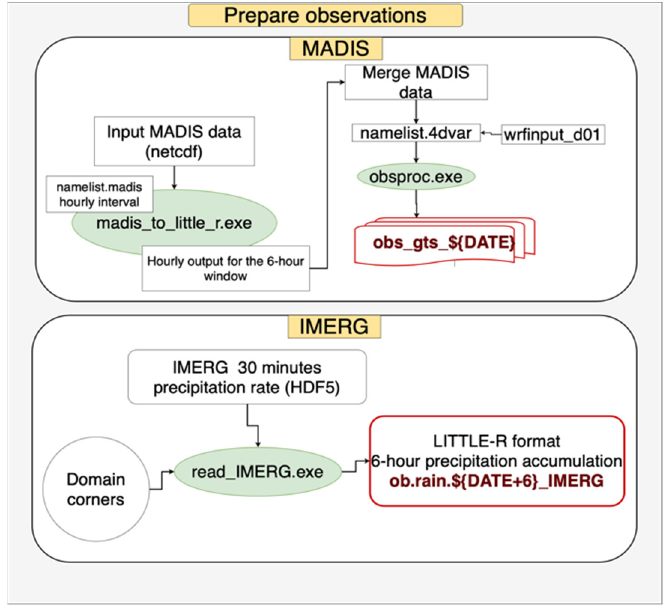
Figure 4. Flowchart of the preprocessing steps for MADIS and IMERG data. In green are the executed components, and highlighted in red are the final files to be ingested in the WRFDA system.